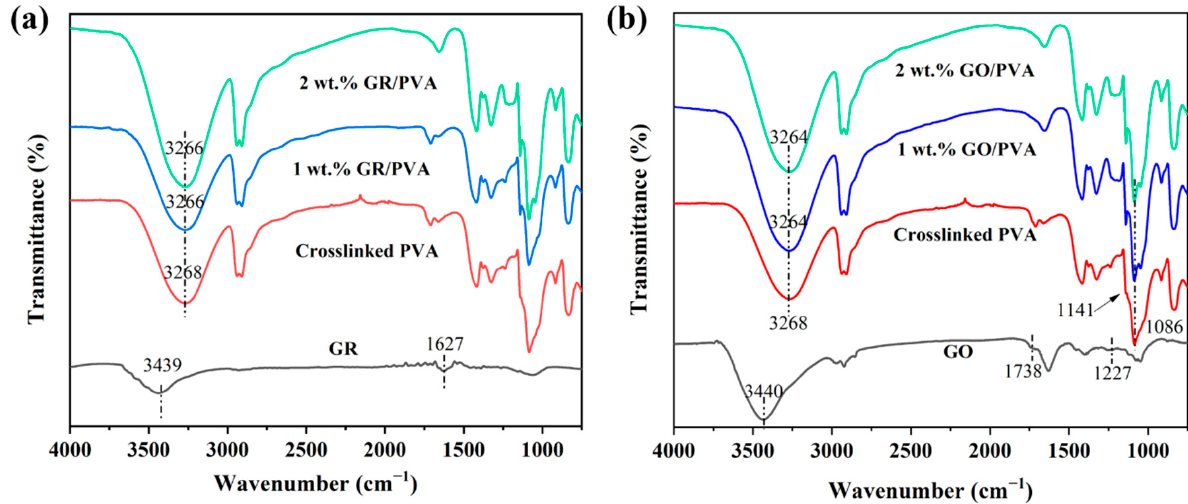
Figure 3. FT-IR spectra of GR/PVA MMMs ( a ) and GO/PVA MMMs ( b